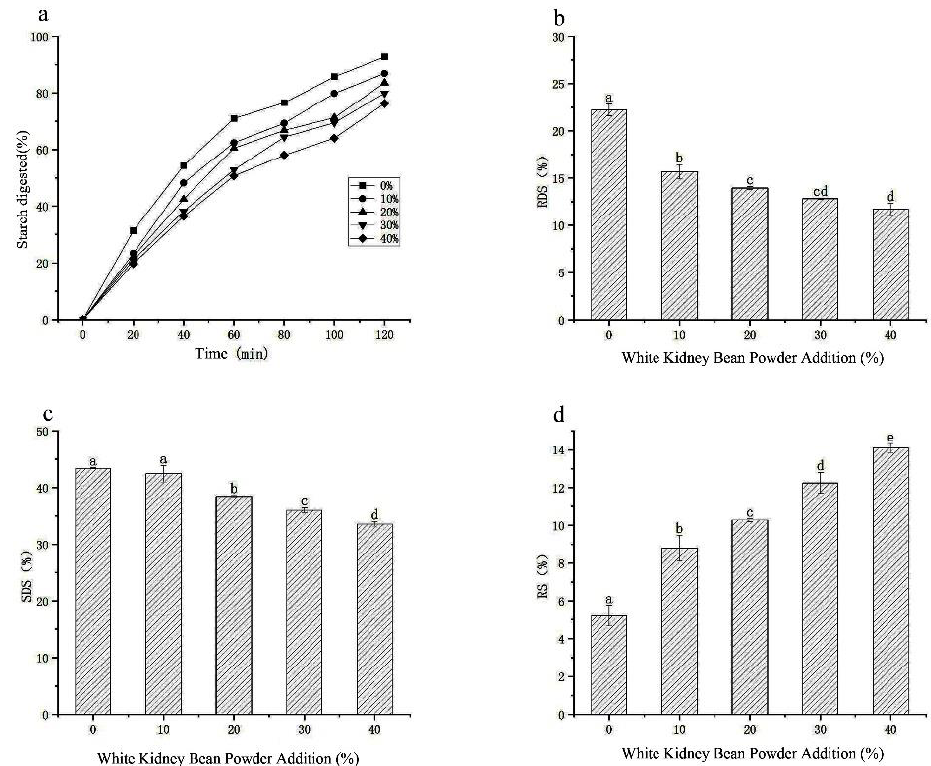
Figure 5. Digestion diagram of white kidney bean flour noodles with different additions: ( a ) starch hydrolysis rate; ( b ) fast digestible starch content (RDS represents fast digestible starch); ( c ) slowly digesting starch content (SDS represents slowly digestible starch); ( d) resistant starch content. Duncan’s statistical methods were used. Different letters within the same group denote significant difference ( p < 0.05).